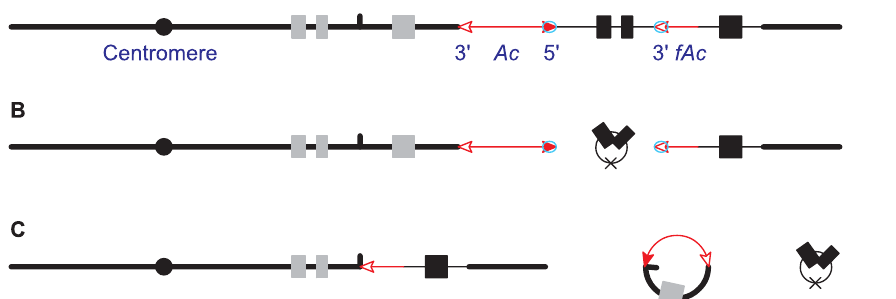
Figure 2. Deletions by Reversed Ac Ends Transposition Generate Chimerical Genes The solid circle indicates the centromere, the short vertical line indicates the target site, and the other symbols have the same meaning as those in Figure 1. (For animated version, see Video S1). (A) Ac transposase (blue oval) binds to the 5 9 end of Ac and 3 9 end of fAc . (B) As in ordinary transposition, the Ac 5 9 end and the fAc 3 9 end are excised by transposase cleavage, and the sequences flanking the Ac/fAc ends join together to form a ; 13-kb circle. The X mark at the junction indicates the transposon footprint. (C) The excised transposon ends insert into a site in intron 2 of p2 . The Ac 5 9 end joins to the distal side of the insertion site to form a circle, and the fAc 3 9 end joins to the proximal side of the insertion site to generate a chimeric gene containing exon 1 and exon 2 of p2 and exon 3 of p1 . This study reports the isolation of the progenitor (A) and deletion products (C). Note that the hypothetical structures shown in (B) are transient in nature and would not be amenable to physical isolation. DOI: